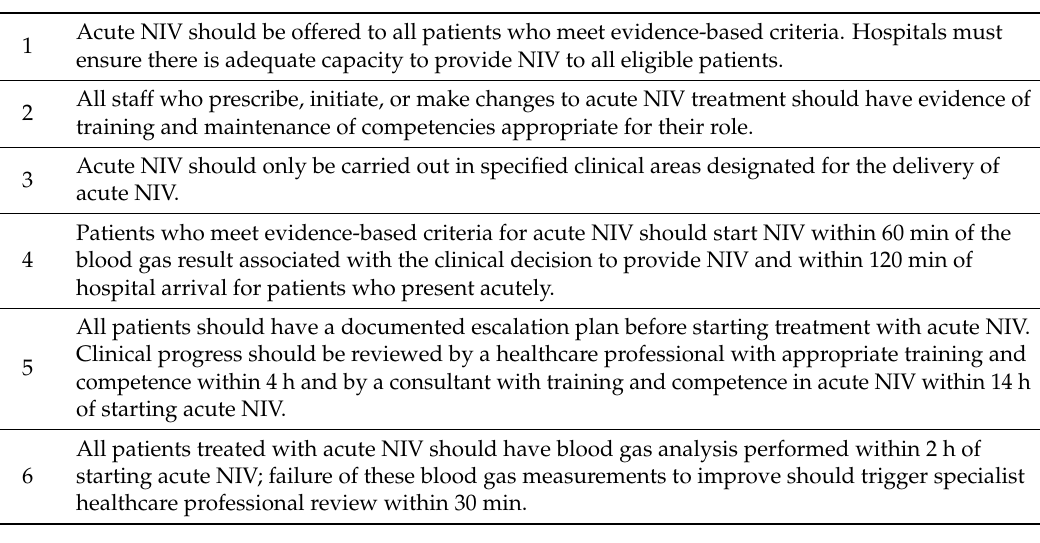
Table 1. British Thoracic Society Quality Statements for acute NIV in